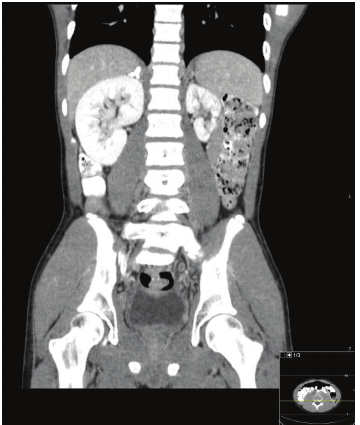
Figure 4: Contrast enhanced abdominopelvic CT scan. Coronal reformation demonstrating left renal hypoplasia with compensatory right renal hypertrophy. The right adrenal gland is heavily